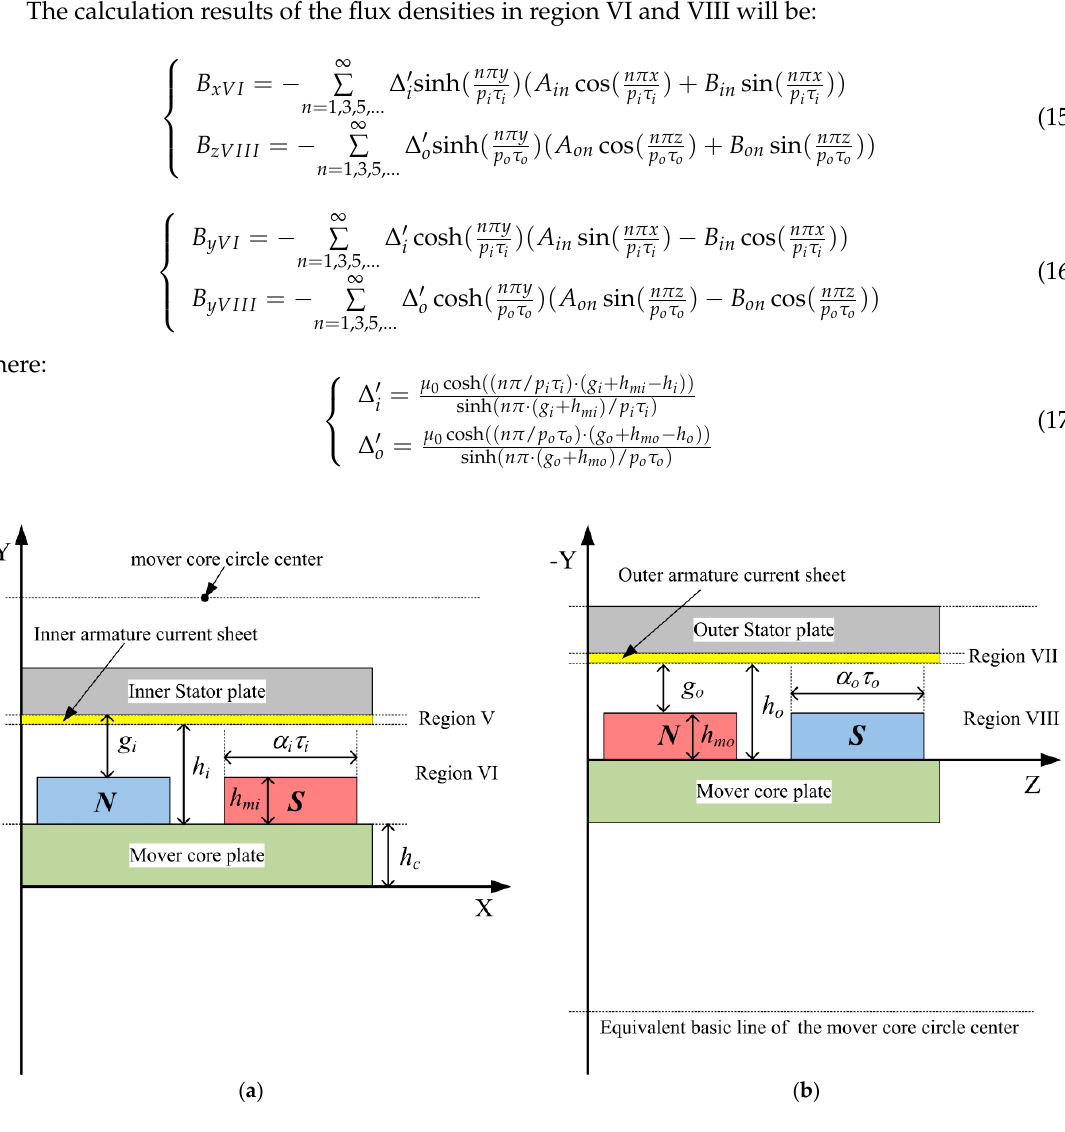
Figure 5. Current sheet model for armature reaction computation. ( a ) Field region of the rotary motion unit in XY plane; and ( b ) field region of the linear motion unit in ZY plane.